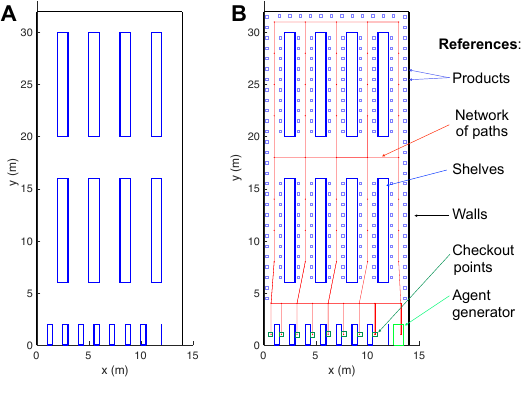
Figure 2: The ideal supermarket layout. A: Only walls and obstacles. B: The other model components as de- scribed in section